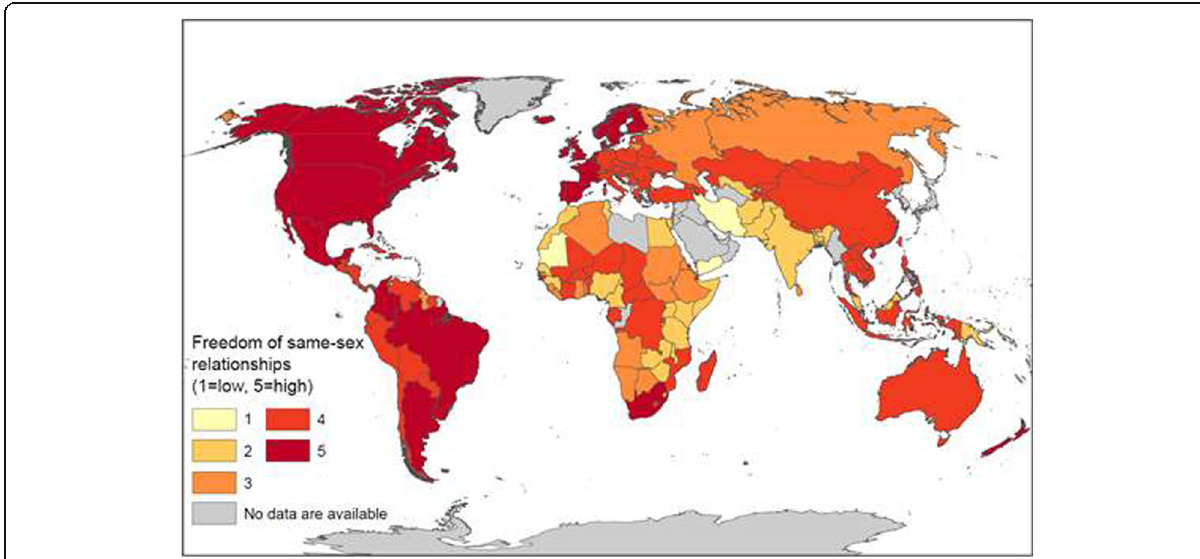
Fig. 3 Global pattern of LGBT Freedom with larger numbers indicating higher levels of LGBT freedom (Source: Created with data from Wikipedia Commons on laws related to same-sex relationships and expression by country. See text in 2.1 for a detailed